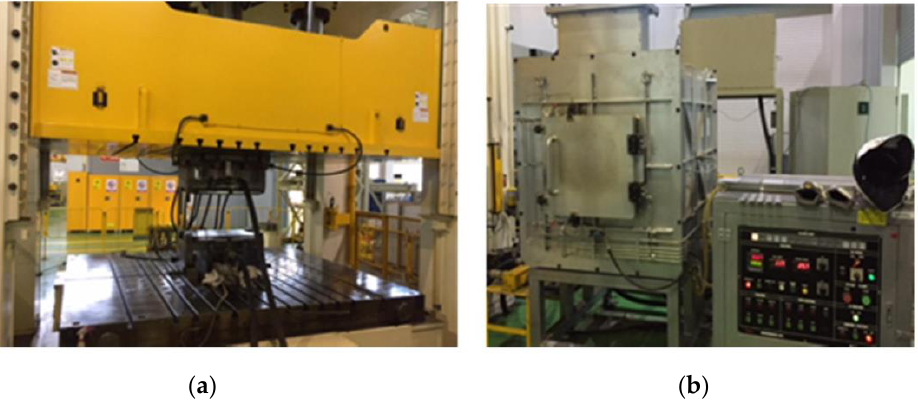
Figure 1. The equipment for simulating the hot stamping procedure: ( a ) the die quenching and ( b ) the heating furnace with control of the atmosphere condition.